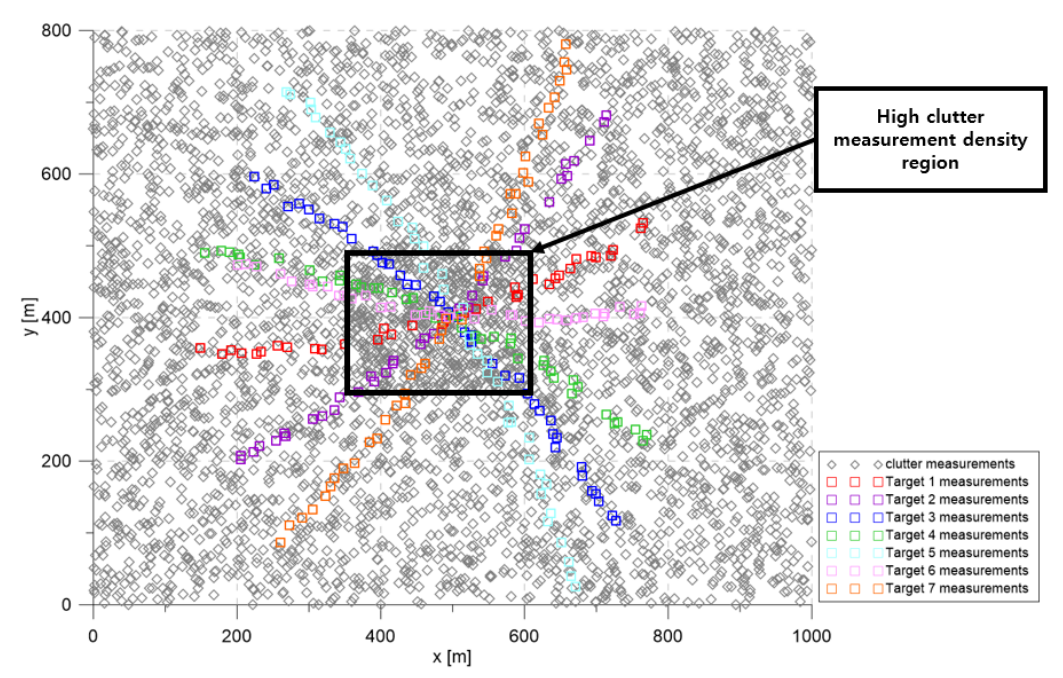
Figure 12. Simulation scenario with seven targets.